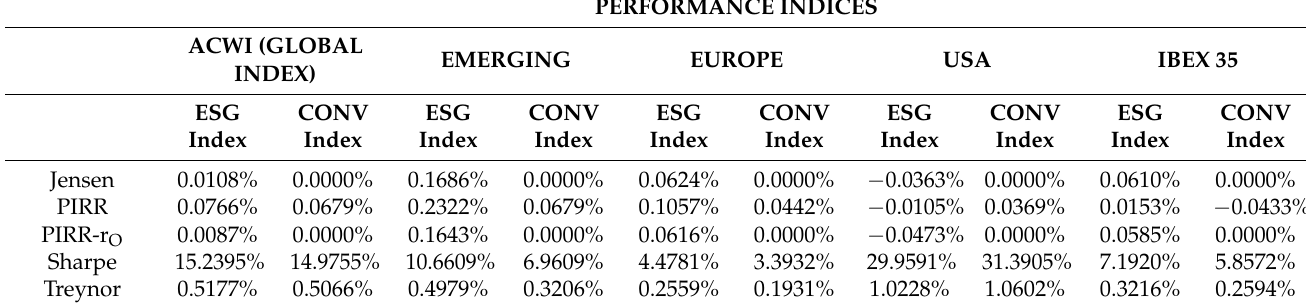
Table 7. Performance